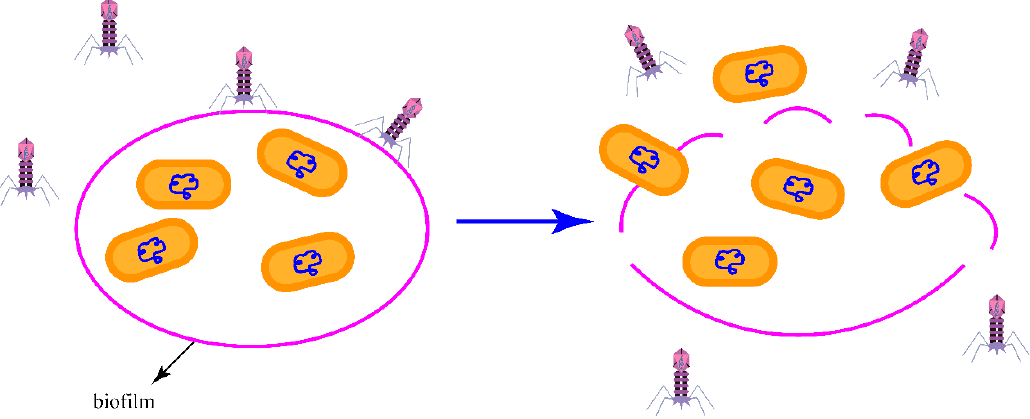
Figure 4. Phages act on biofilms, destroying the biofilm matrix, exposing receptors on the bacterial surface, and initiating the phage replication cycle. In addition, phage lysis of biofilms also increases the permeability to antibiotics, restoring the eradication effect of antibiotics on bacteria.